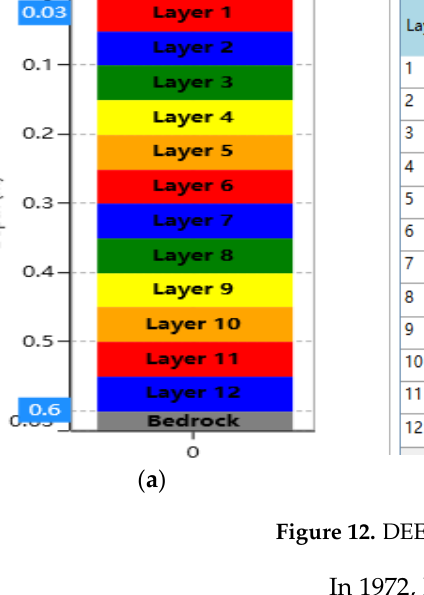
where, 𝐺 (cid:3040)(cid:3028)(cid:3051) is the small − strain shear modulus , 𝛾 (cid:3045) is the reference strain , 𝛾 is the shearing strain and α is the regression parameter.